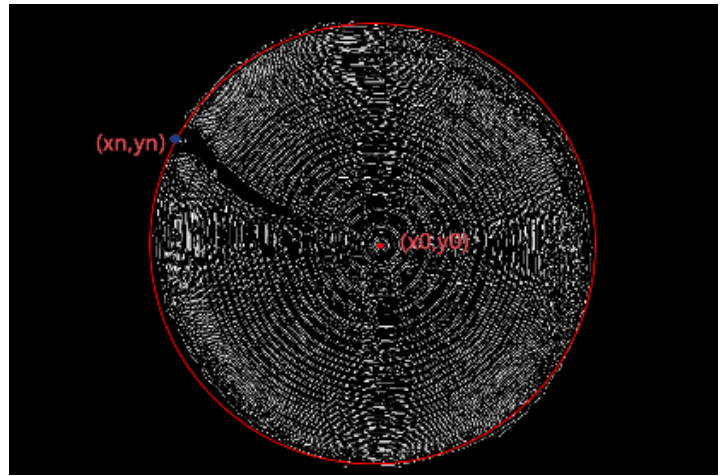
Figure 3. Edges information of a wood image with the center points ( x 0 , y 0 ) and the points of the largest circle ( x n , y n ) .